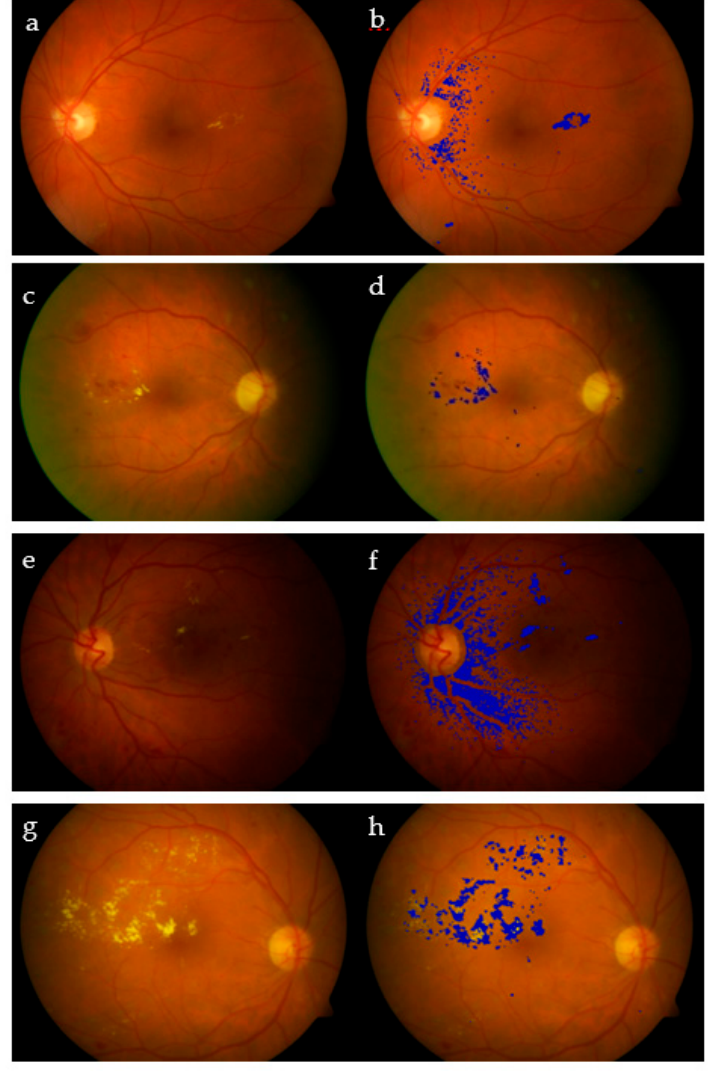
17 of 20 Figure 14. FCM clustering: RGB expected exudates ( a ); GT ( b ); clusters C 1 ( c ) and C 2 ( d ); red repre- sents extracted exudates, while white pixels refer to the GT ( e ); superimposed results on the origi- nal image ( f ); extracted exudates after morphological processing ( g ); superimposed results after mathematical morphology ( h ). The proposed algorithm showed remarkably high specificity, which shows its ability to avoid recognizing a non-exudate pixel as an exudate. However, the sensitivity had a lower value due to those exudates with low intensity, which are still hard to detect per- fectly [34]. For the sake of completeness, we report for the DIARETDB dataset the best (Image #27 with Se = 99.2% / 99.8%; Image #16 with Acc = 97.6%/99.0%) and the worst cases (Image #16 with Se = 62.9%/76.0%; Image #27 with Acc = 93.7%/94.9%) evaluated, using